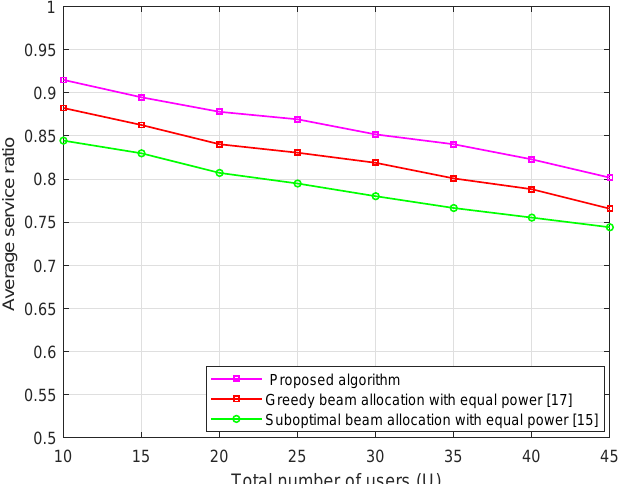
Figure 4. Average service ratio versus total number of users U with α = 2, M = 64, P t = 30 dBm.